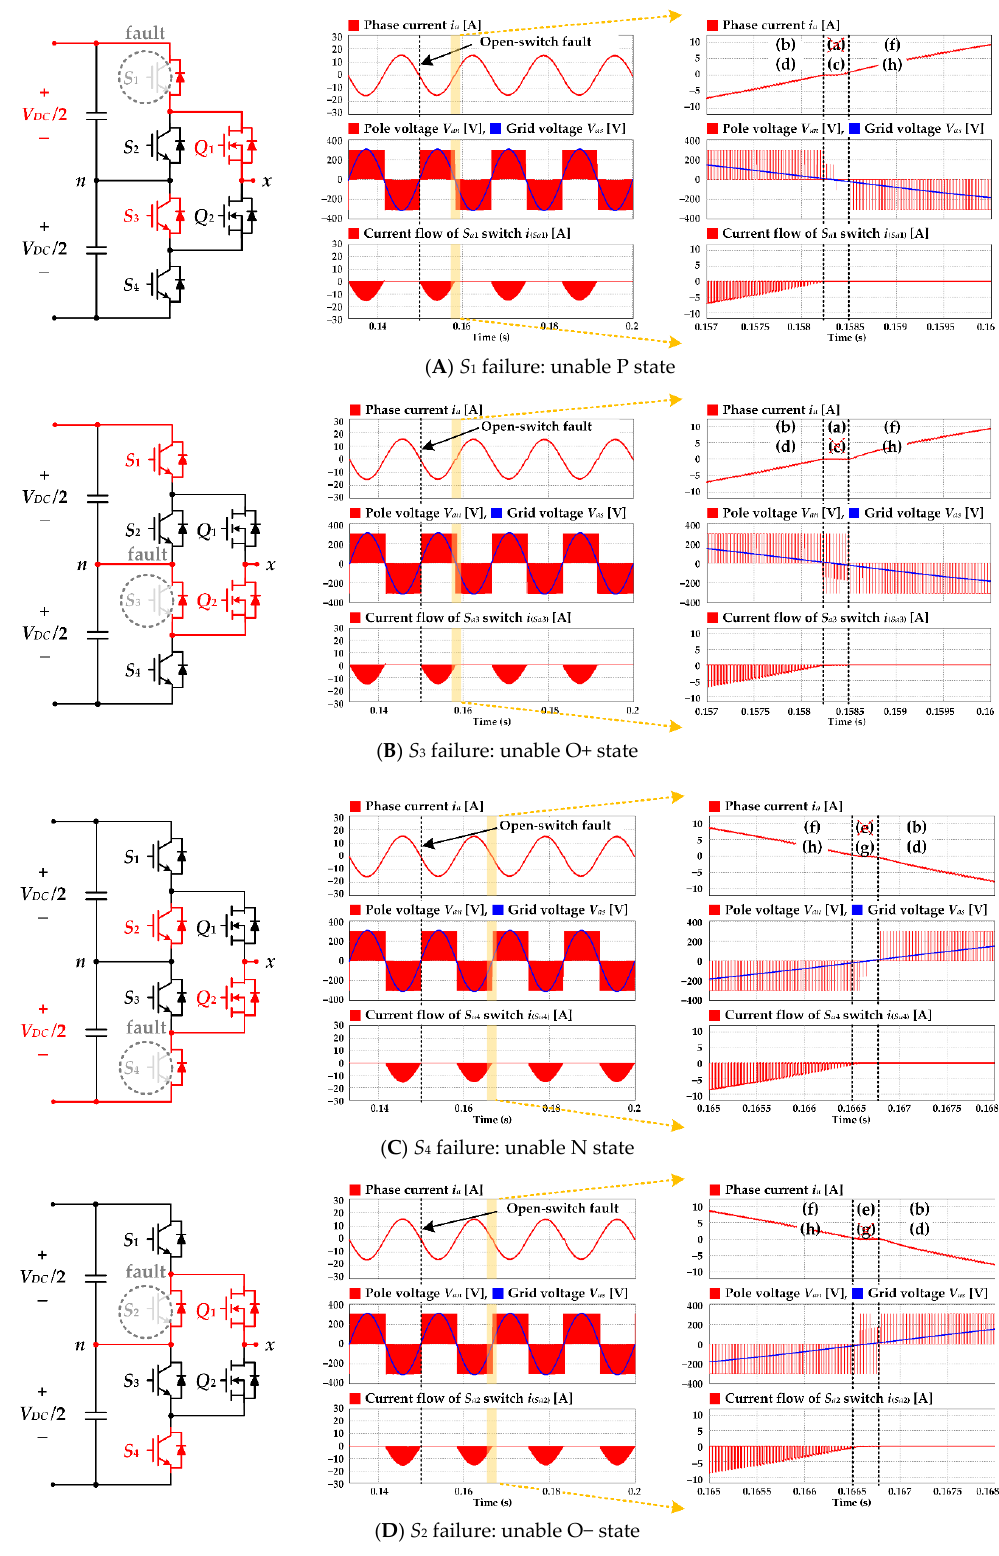
Figure 5. Phase current and pole voltage under each IGBT faulty condition in the HANPC rectifier.